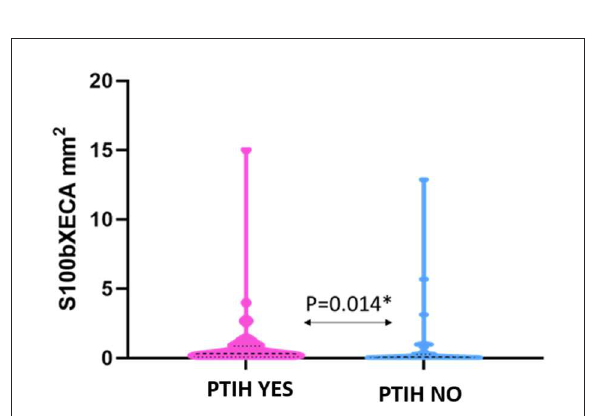
FIGURE3 Violin plot showing that S100b expression in clots from patients with PTIH is significantly higher than patients without signs of hemorrhage. Dashed lines represent the median while dotted lines represent the interquartile ranges, Q1 (lower dotted lines) and Q3 (upper dotted lines) . *Statistically